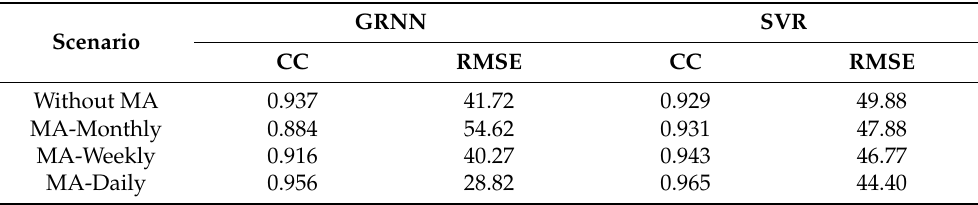
Table 5. Results of prediction by using GRNN and SVR model with various scenario with Moving Average (M.A.) values; Monthly, Weekly, and